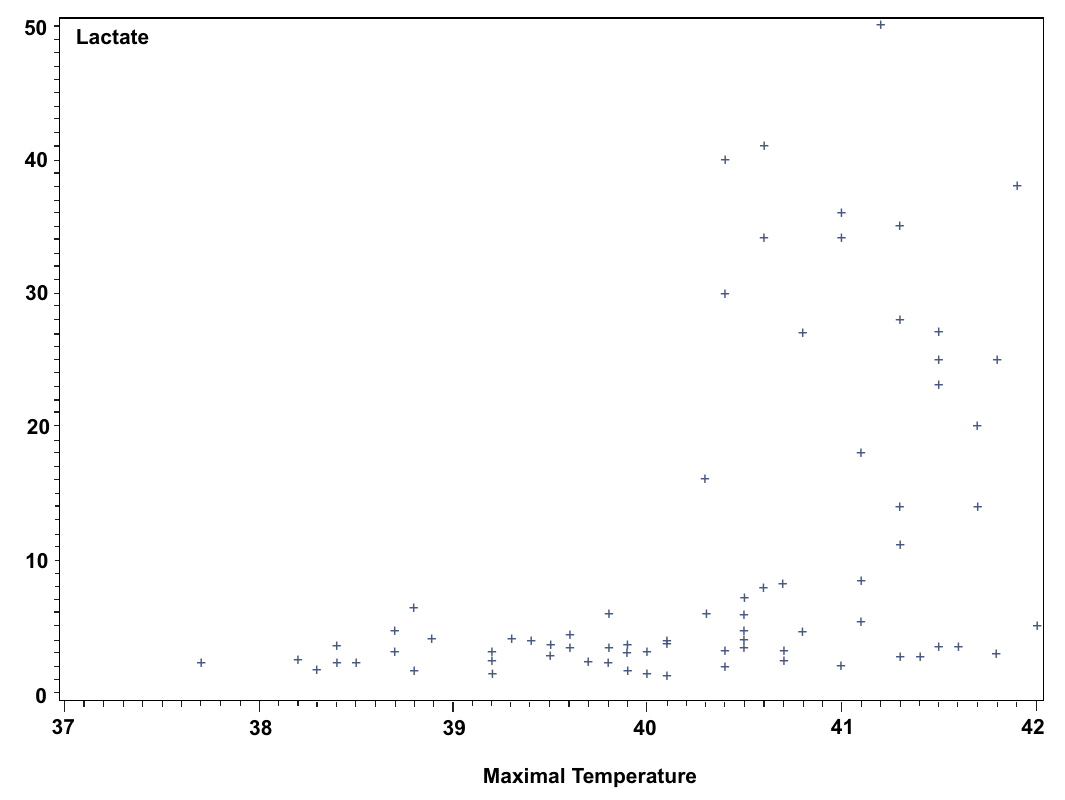
Figure 16. Blood lactate concentration (mmol/l) versus maximal temperature (°C). Scatterplot showing the relation between blood lactate concentration and